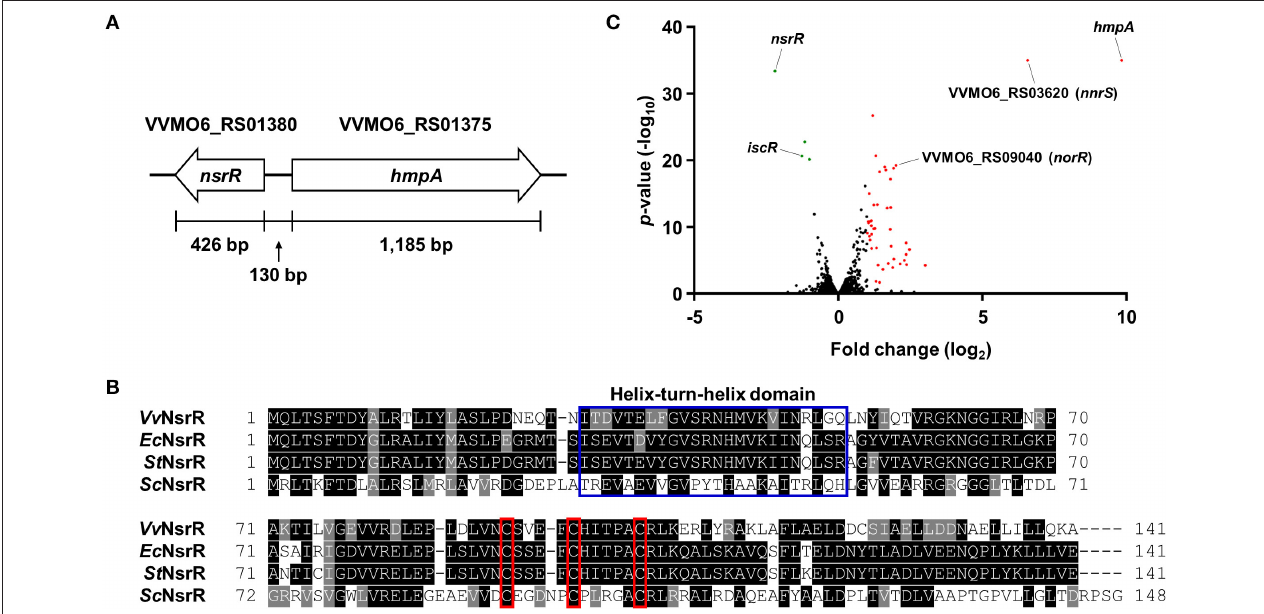
FIGURE 1 | Identification of NsrR and transcriptome analysis of its downstream genes. (A) The physical map of nsrR and hmpA on the V. vulnificus MO6-24/O genome. The open arrows represent the coding regions and transcriptional directions of the genes. (B) The amino acid sequences of various bacterial NsrRs were retrieved from the NCBI protein database and aligned using the T-Coffee alignment program ( Notredame et al., 2000). Identical sequences and conserved sequences are shaded in black and gray, respectively. Dashed lines represent missing sequences. Conserved helix-turn-helix DNA-binding motif and three cysteine residues potentially involved in the Fe-S cluster ligation are indicated by a blue open box and red open boxes, respectively. Vv NsrR, V. vulnificus NsrR; Ec NsrR, E. coli NsrR; St NsrR, S. Typhimurium NsrR; Sc NsrR, S. coelicolor NsrR. (C) The volcano plot depicting the genes differentially expressed by the nsrR deletion (fold change ≥ 2 with p < 0.05). The red dots and green dots represent the differentially up-regulated and down-regulated genes, respectively.